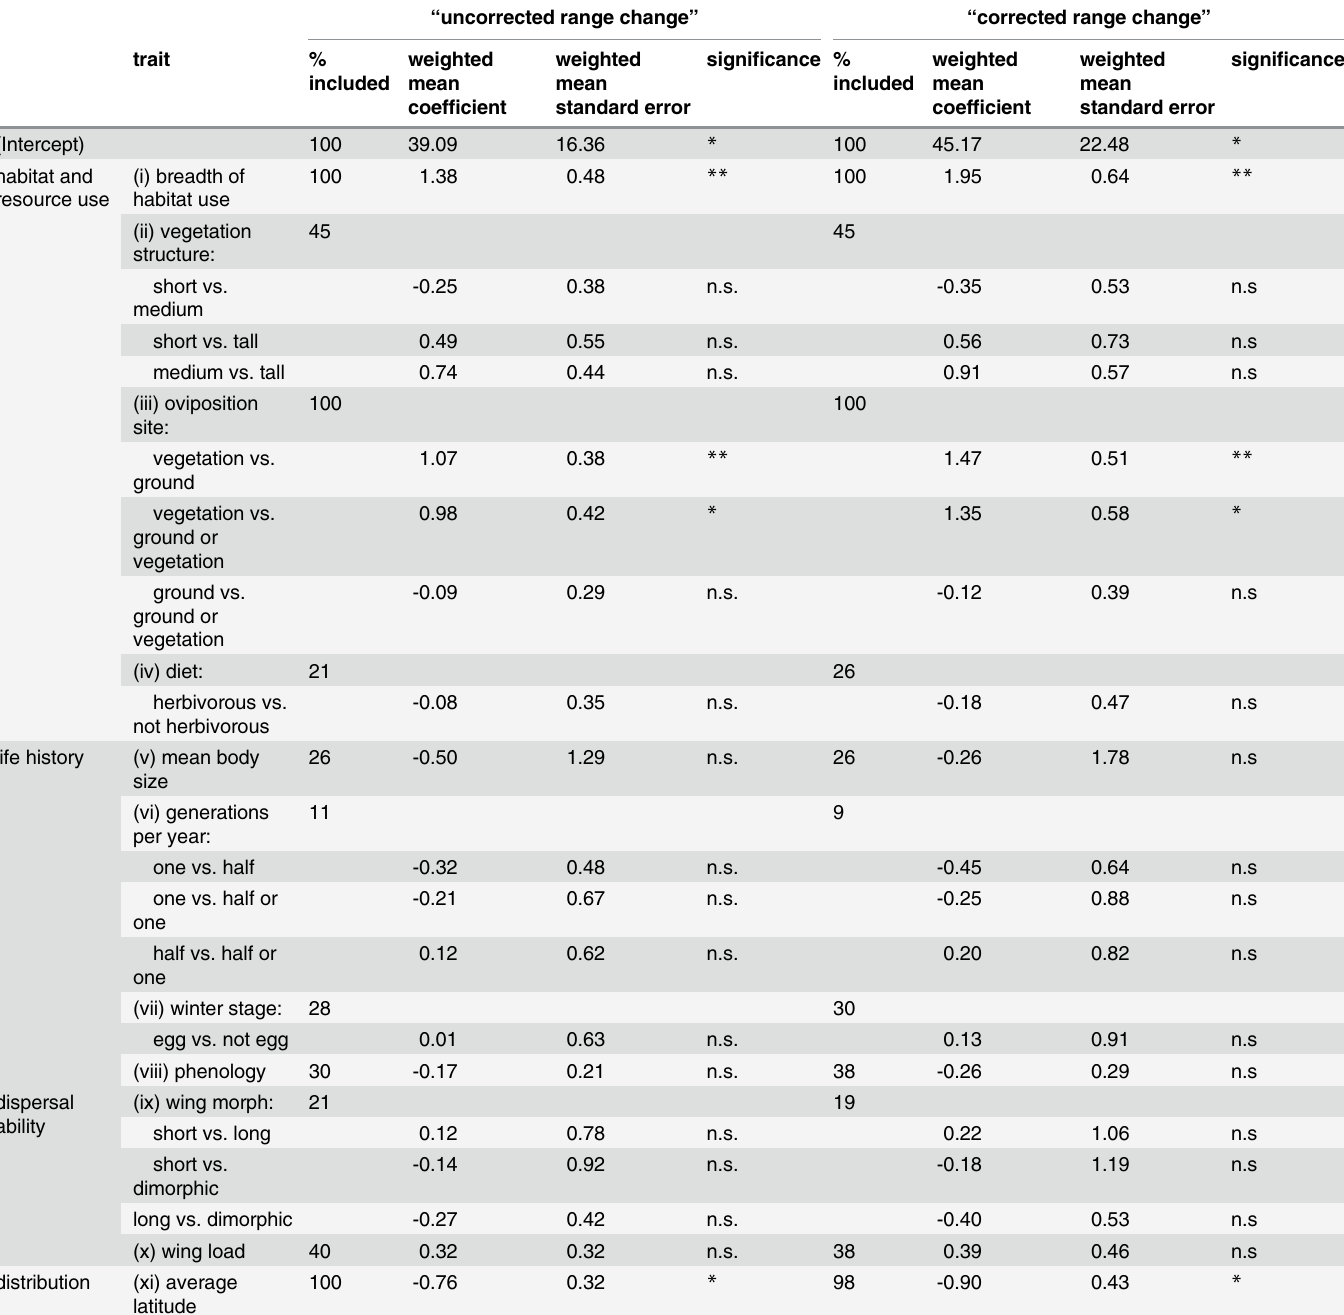
Table 4. Impacts of species traits on distribution changes of British grasshoppers and crickets (all species) between the 1980s and 2000s. “ uncorrected range change ” “ corrected range change ” trait % weighted weighted signi fi cance % weighted weighted signi fi cance included mean mean included mean mean coef fi cient standard error coef fi cient standard error (Intercept) 100 39.09 habitat and (i) breadth of resource use habitat use